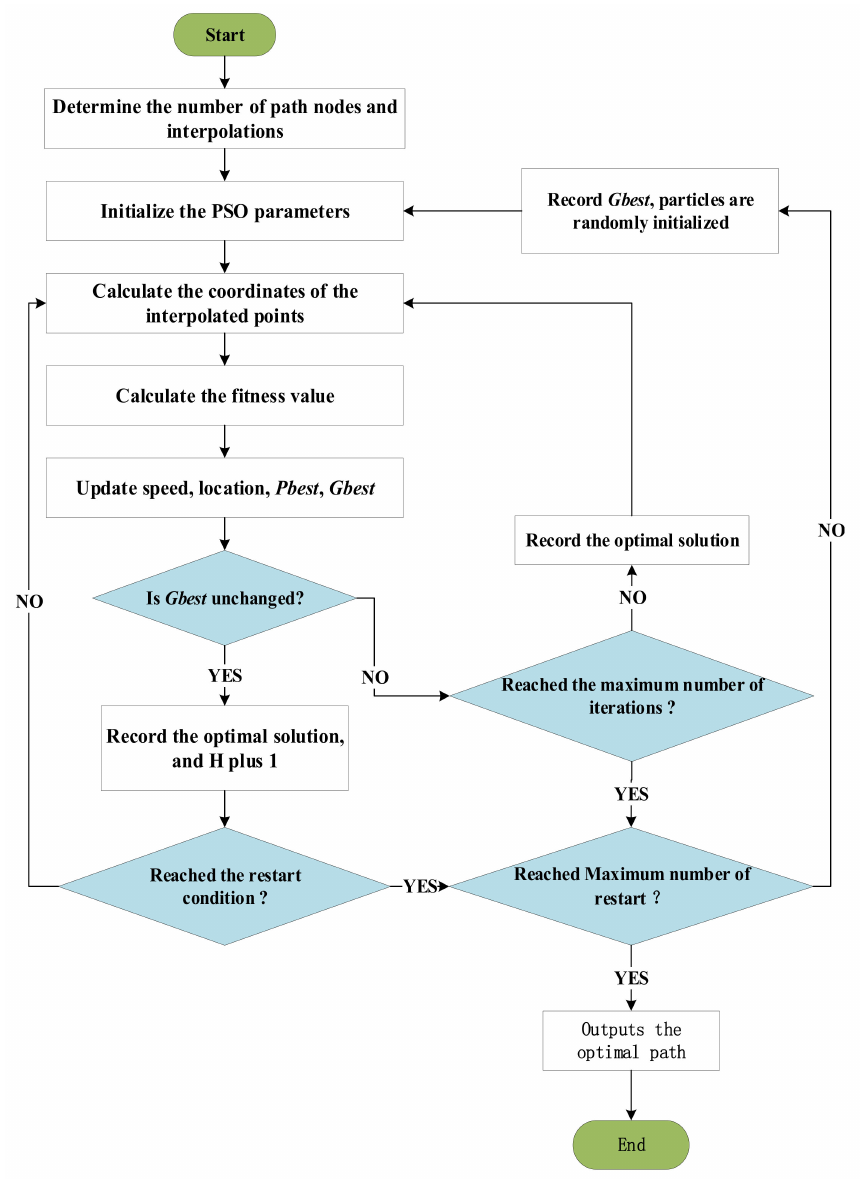
Figure 2. Flowchart of the RDS-PSO